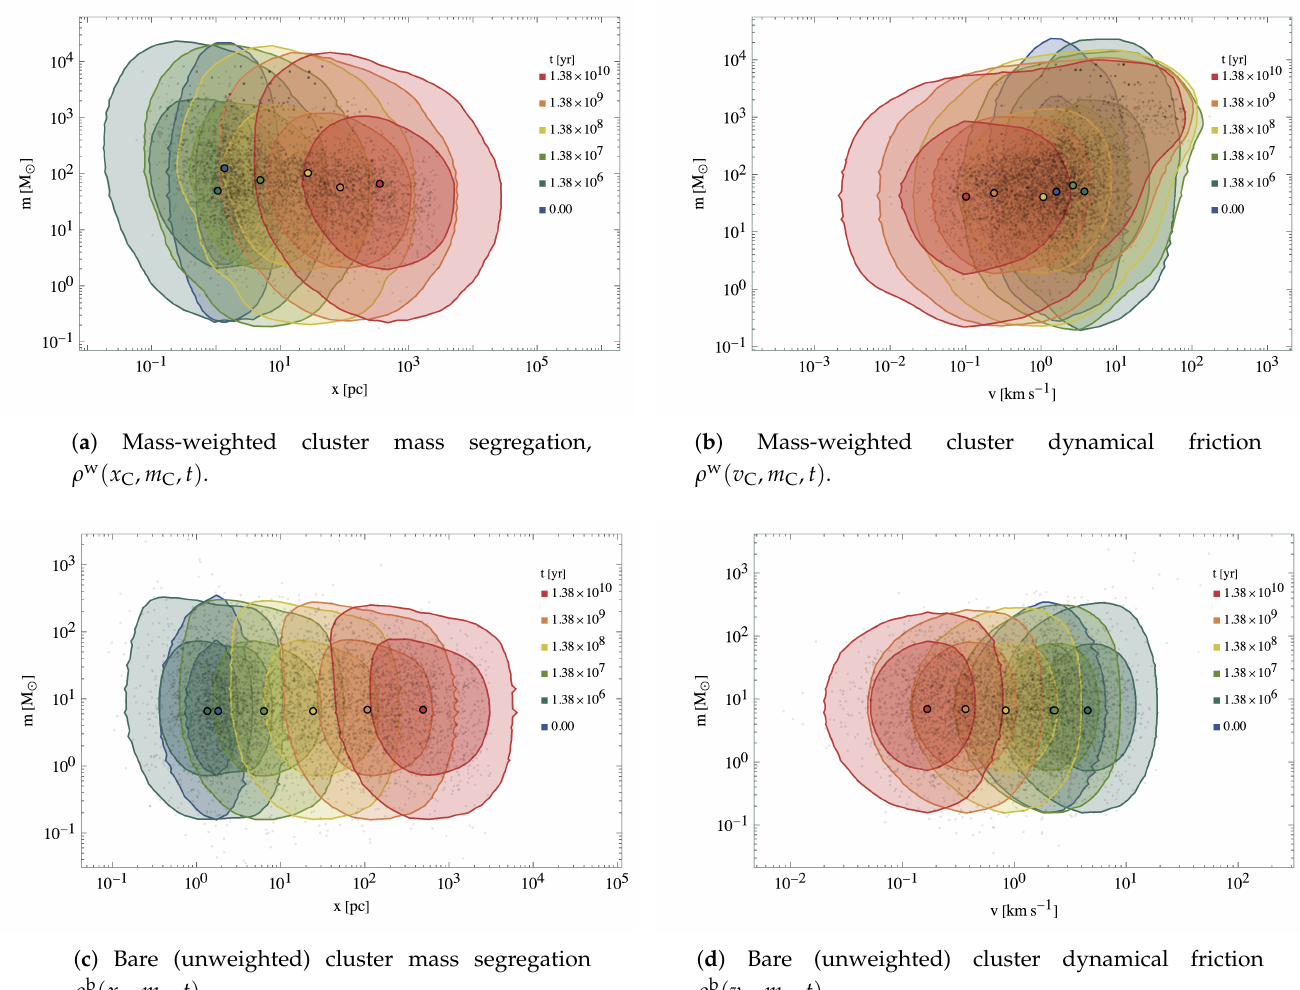
Figure 13. Shown are the 1 σ and 2 σ contours for the cluster PBHs mass vs. position and velocity distributions at selected times. Fits for the mass, position, velocity and density probability distributions are given in Table 16. Black dots show the scatter a 1000 sample of individual PBHs in each time slice, randomly selected in the case of the bare distribution and selected with a probability proportional to their mass in the case of the mass weighted in order to better illustrate mass segregation and dynamical friction, as otherwise such very massive PBHs are easy to miss in the sample given that there are not more than O ( 1 ) m i > 1000M (cid:12) massive objects per cluster. The Best-Fit (BF) values of the distributions, marked by the large coloured dots, are given in Table